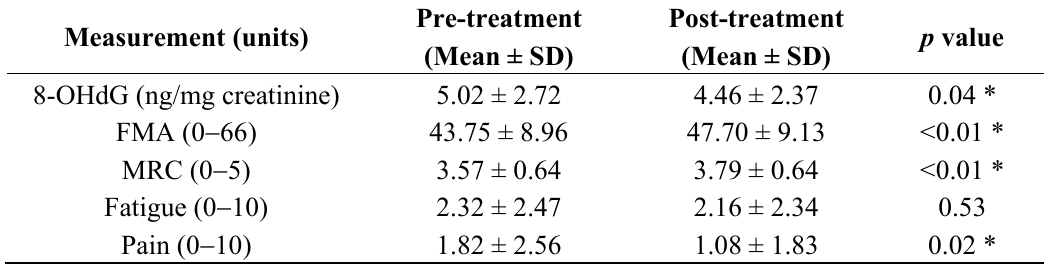
Table 5. Effects of 4-week rehabilitation intervention on 8-OHdG levels and functional outcomes in patients with stroke ( N = 61). Abbreviations: 8-OHdG, 8-hydroxy-2'- deoxyguanosine; FMA, Fugl-Meyer Assessment; MRC, Medical Research Council scale; SD, standard deviation. * p <